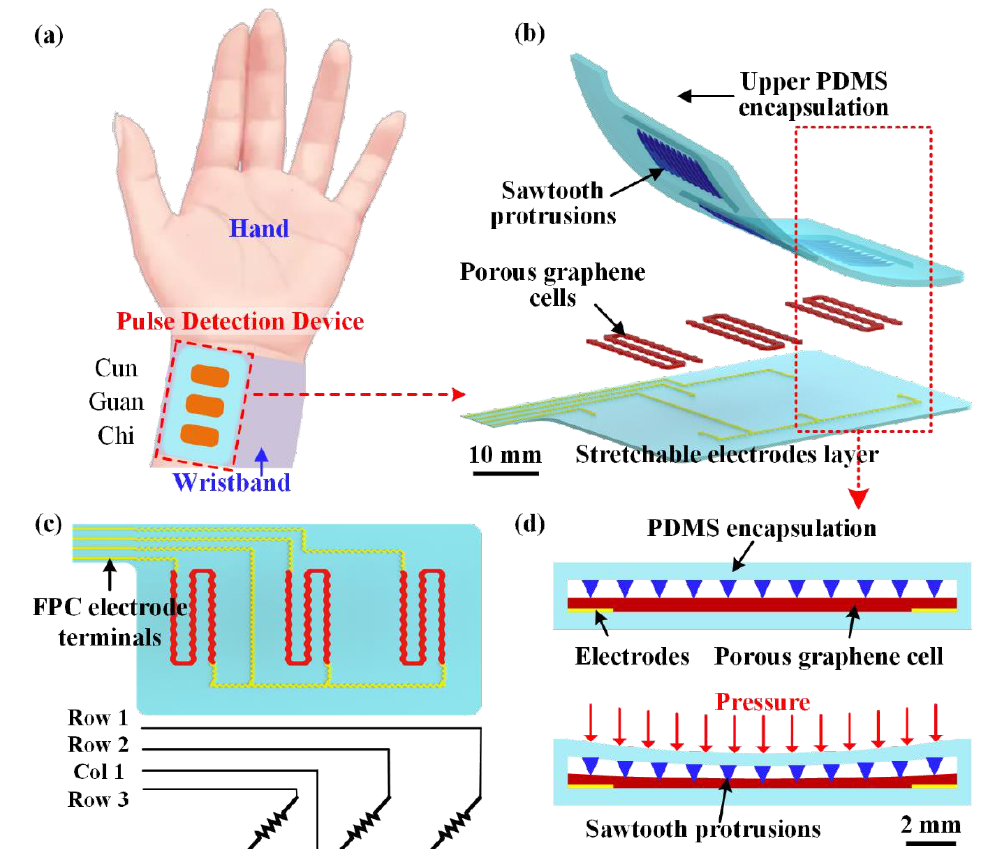
Figure 1. ( a ) Schematic view of wearable pulse detection device for radial pulse monitoring; ( b ) the multilayer structure of pulse detection device; ( c ) electrode connection of porous graphene cells and measurement circuit; ( d ) the pressure-sensing principle of the pulse detection device.